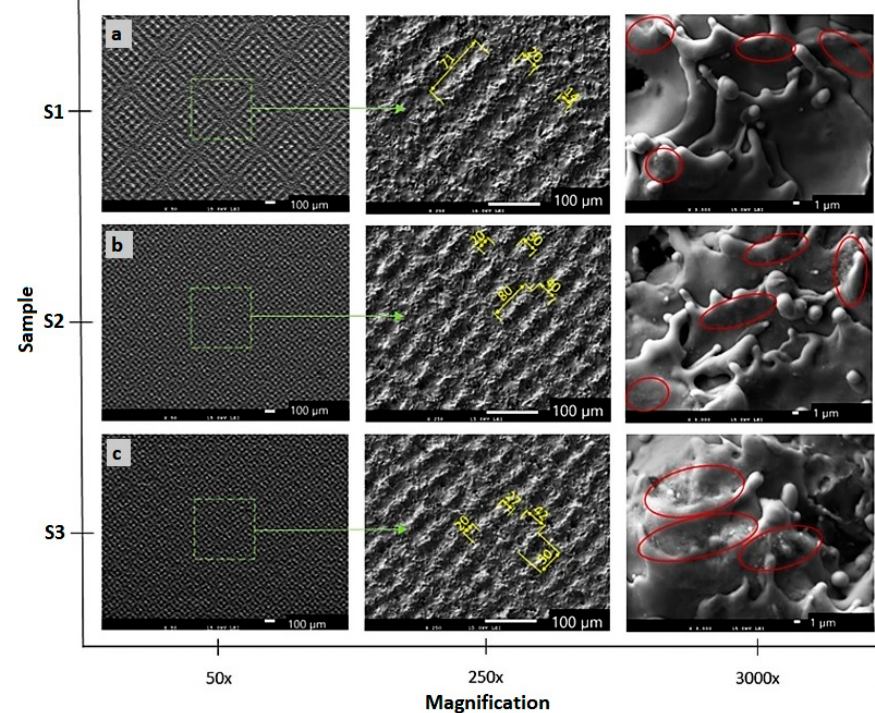
Figure 4. Scanning electron microscopy (SEM) micrographs (original magnifications of 50 × , 250 × and 3000 × ) of the machined surfaces. ( a ) surface S1 (total energy delivered to the material per illuminated area (E T ) = 0.5 mJ); ( b ) surface S2 (E T = 1 mJ); ( c ) surface S3 (E T = 5 mJ). Areas containing oxides are indicated in red.